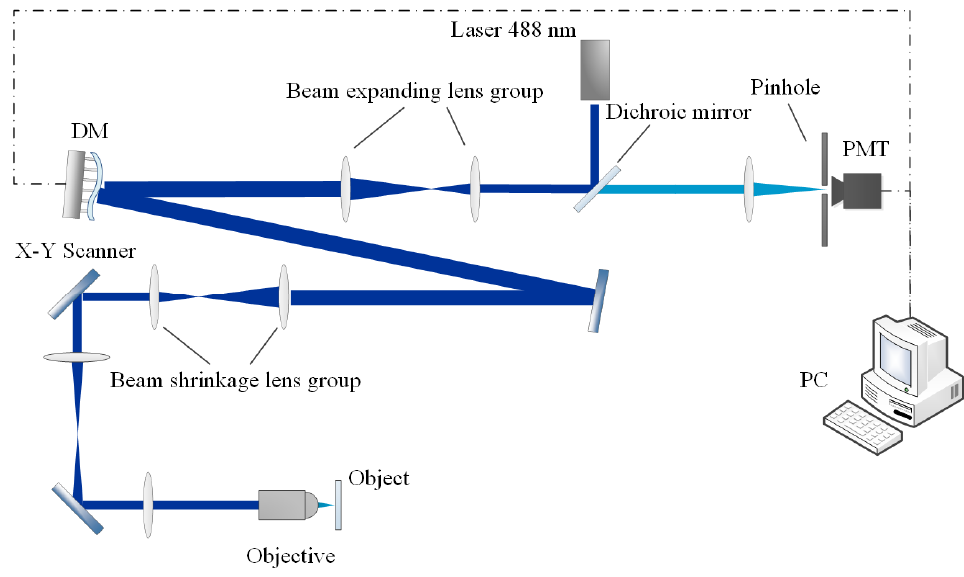
Figure 1. Structure of the AO system for LSCM.